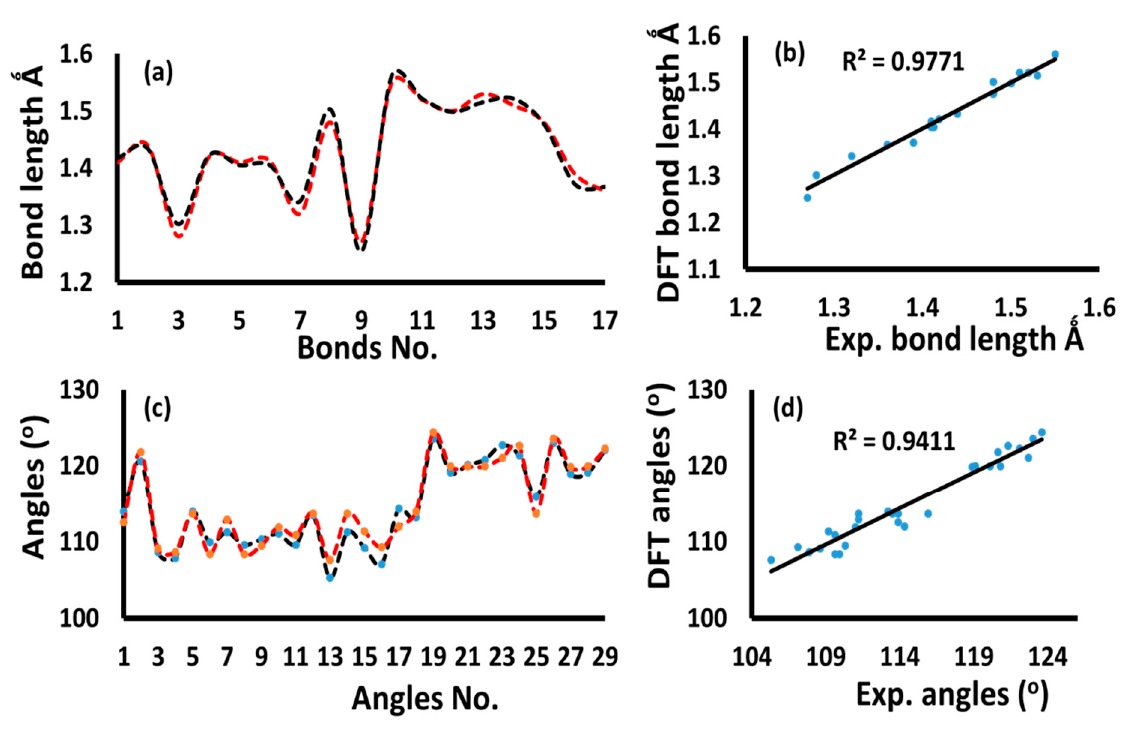
Figure 2. ( a ) DFT/XRD bond length histogram and its ( b ) graphical correlation, ( c ) DFT/XRD angles histogram, and ( d ) graphical correlation.